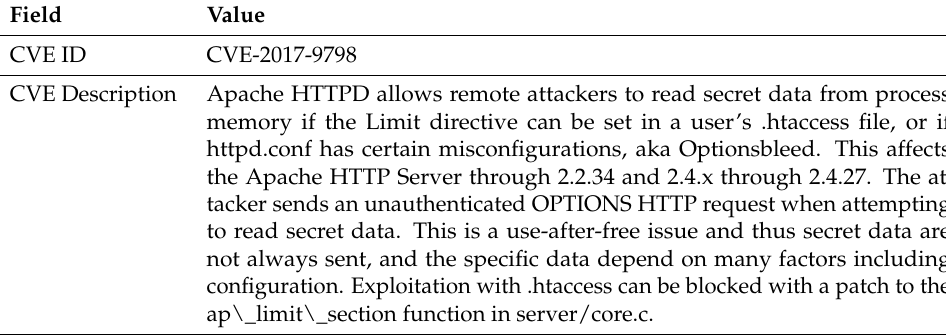
Table 2. Example of